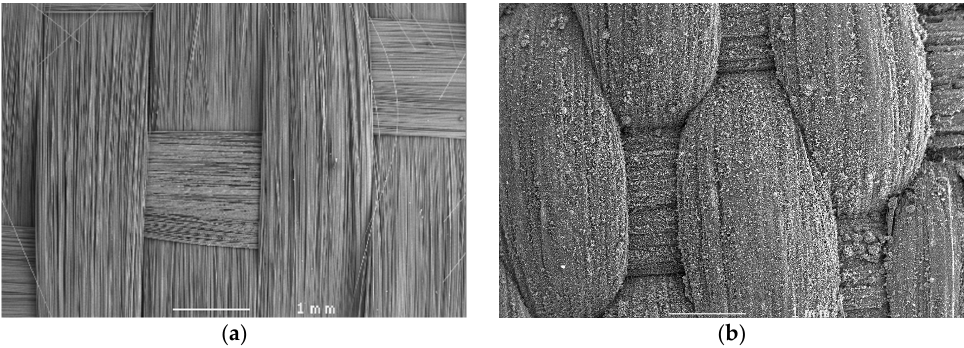
Figure 3. Base ( a ) and highly grafted ( b , after a high 2.9 wt % Ni loading with acetone solution) fabrics.